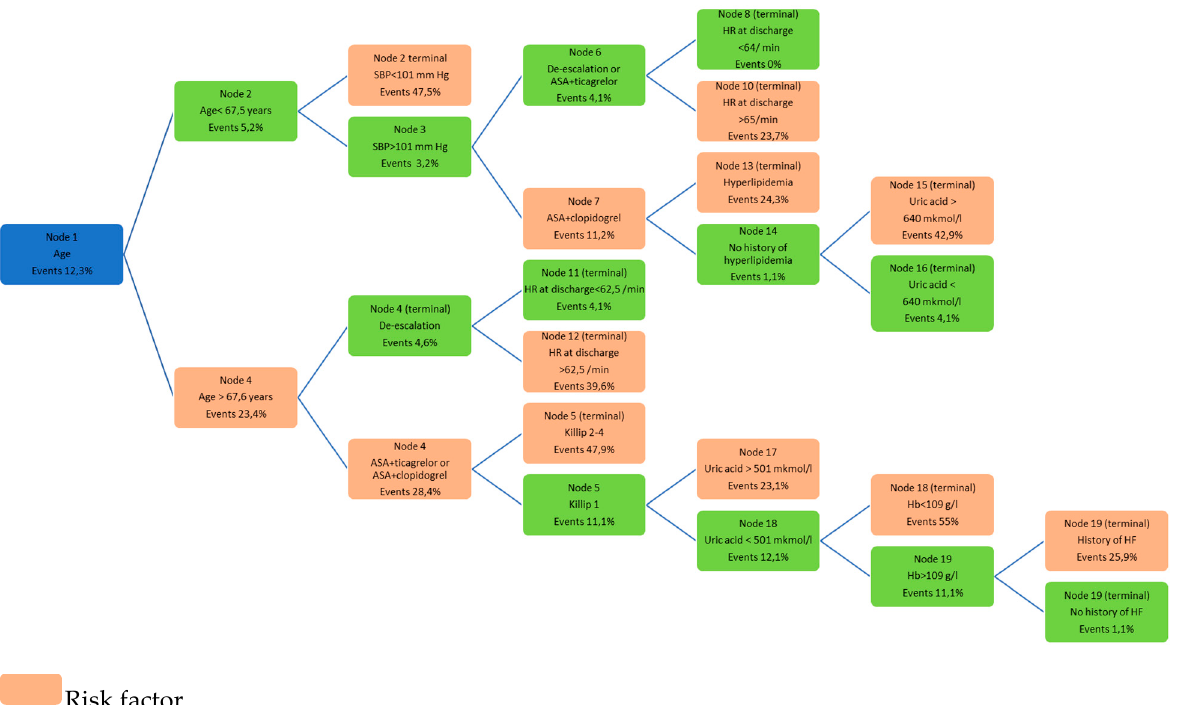
Figure 1. Probabilities of the event development for each terminal node in the optimal classification model. Footnote: HR-heart rate, ASA-acetylsalicylic acid, HF-heart failure, Hb-hemoglobin, SBP-systolic bood pressure.